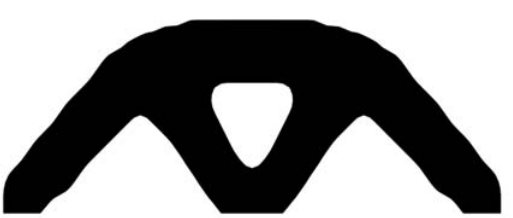
Figure 20. Optimized shape of simple bridge beam with a volume fraction of 0.75.